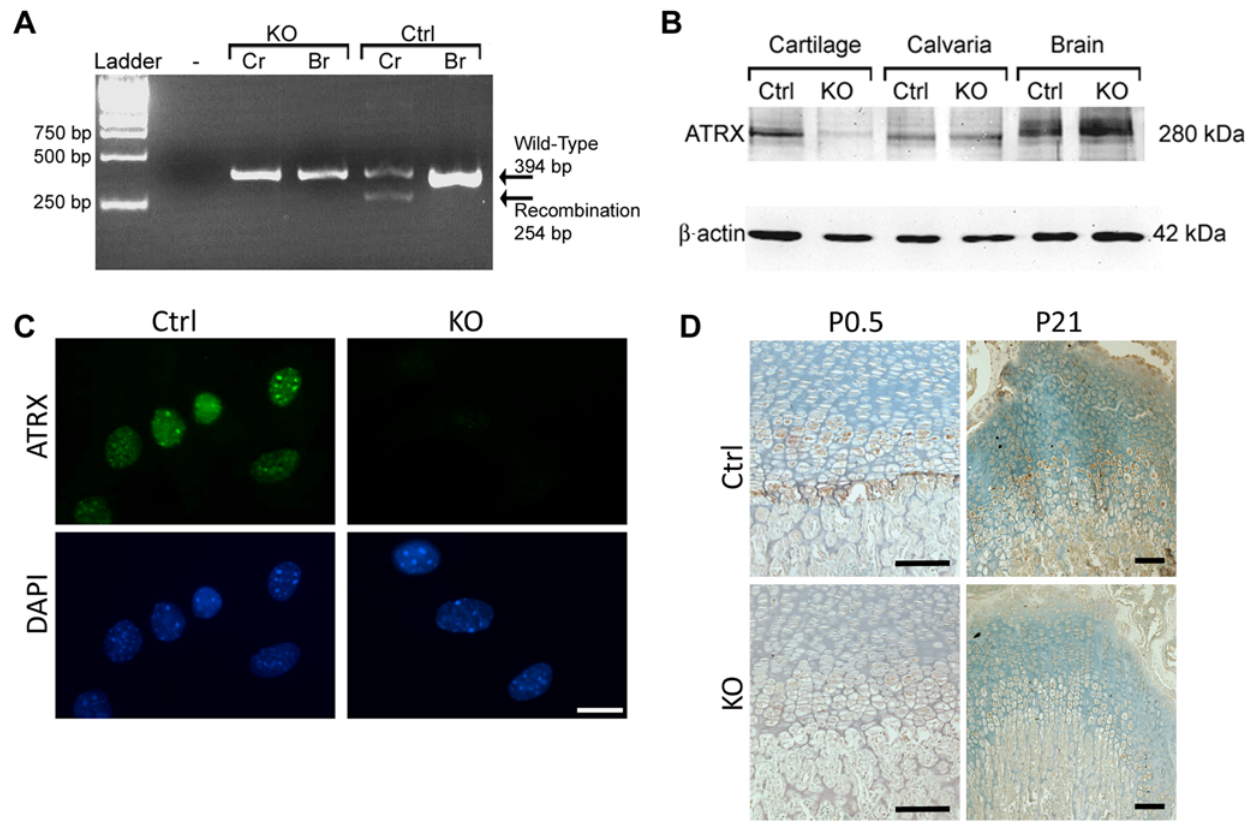
Figure 2. Levels of ATRX are decreased in the cartilage of Atrx Col2Cre mice. (A) RT-PCR analysis of RNA isolated from newborn rib cartilage (Cr) or brain (Br) from Atrx Col2Cre males (KO) and control littermates (Ctrl). Amplification was performed with primers flanking the loxP sites, in introns 17 and 20. The expected amplicon of 394 bp was obtained in control and an additional amplicon of 254 bp was obtained in KO cartilage caused by the recombination event. The levels of the recombined product are low, as described previously [6,7], suggesting that this product is unstable. (B) Immunoblotting for Atrx from proteins isolated from newborn control and KO rib chondrocytes, calvariae and brain tissue. Atrx expression is greatly reduced in KO chondrocytes, but unaffected in calvariae and brain of KO animals. Beta-actin was used as a loading control. (C) Immunofluorescence detection of ATRX in control and Atrx Col2Cre primary chondrocytes isolated from newborn long bones shows the loss of ATRX protein in KO chondrocytes. Scale bar: 10 m m. (D) Immunohistochemistry on growth plates from P0.5 and P21 mice. ATRX staining is reduced in KO growth plates. Scale bar: 100 m m.